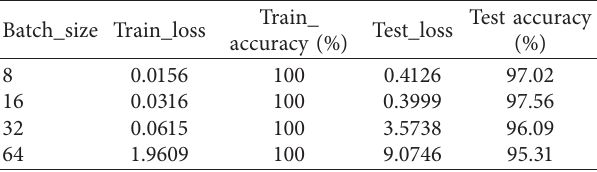
Table 4: Effect of the batch_size on recognition results.